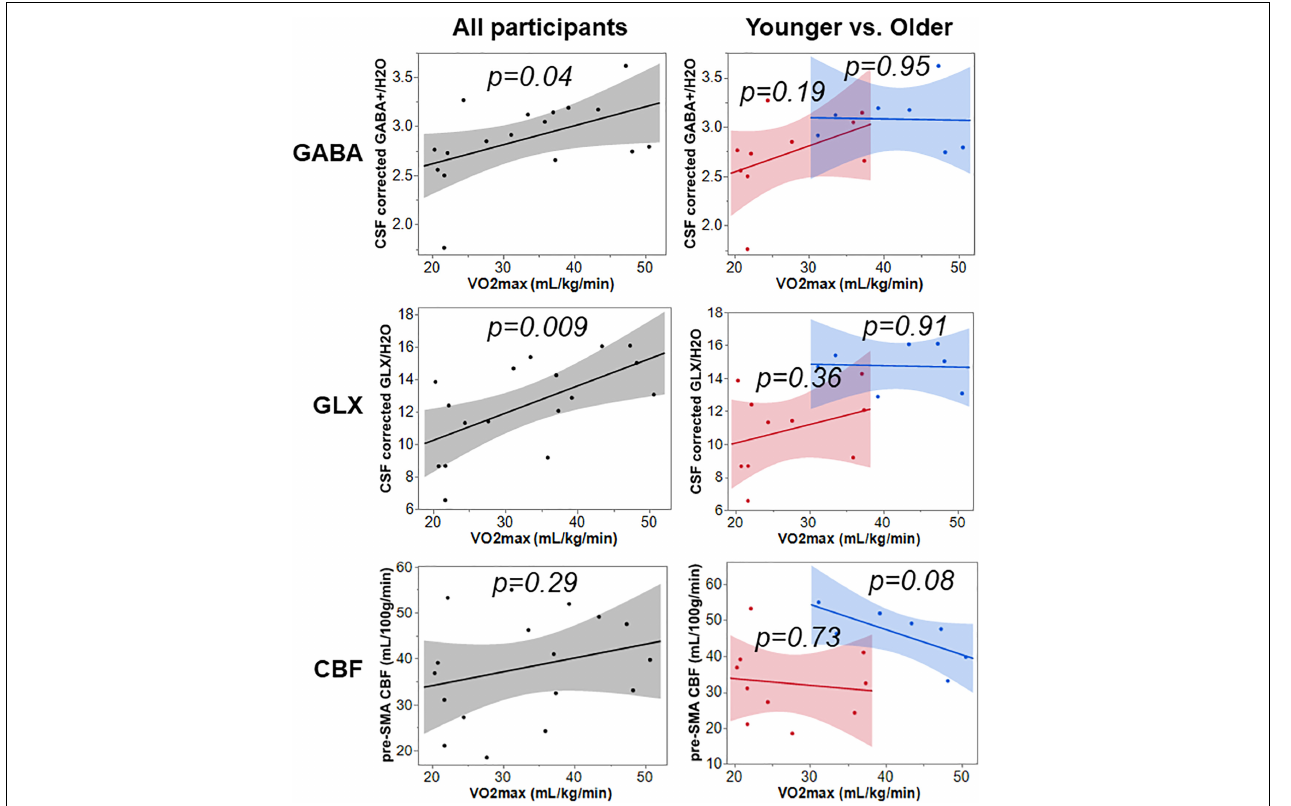
FIGURE 3 | The relationship of VO2max to GABA+, Glx, and CBF across all, younger, and older participants.